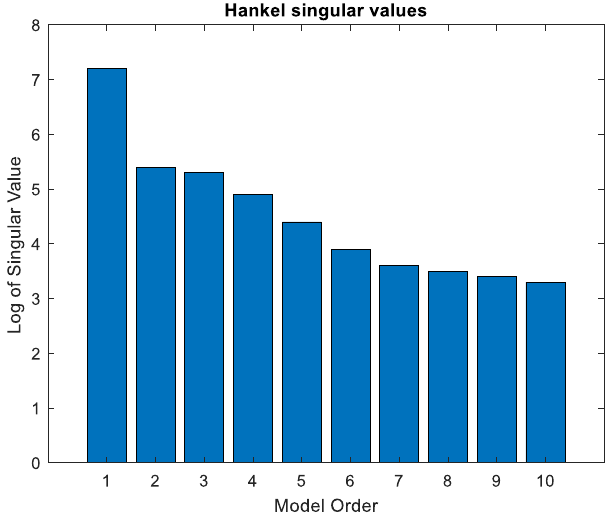
Figure 8. Hankel singular values of estimated models.